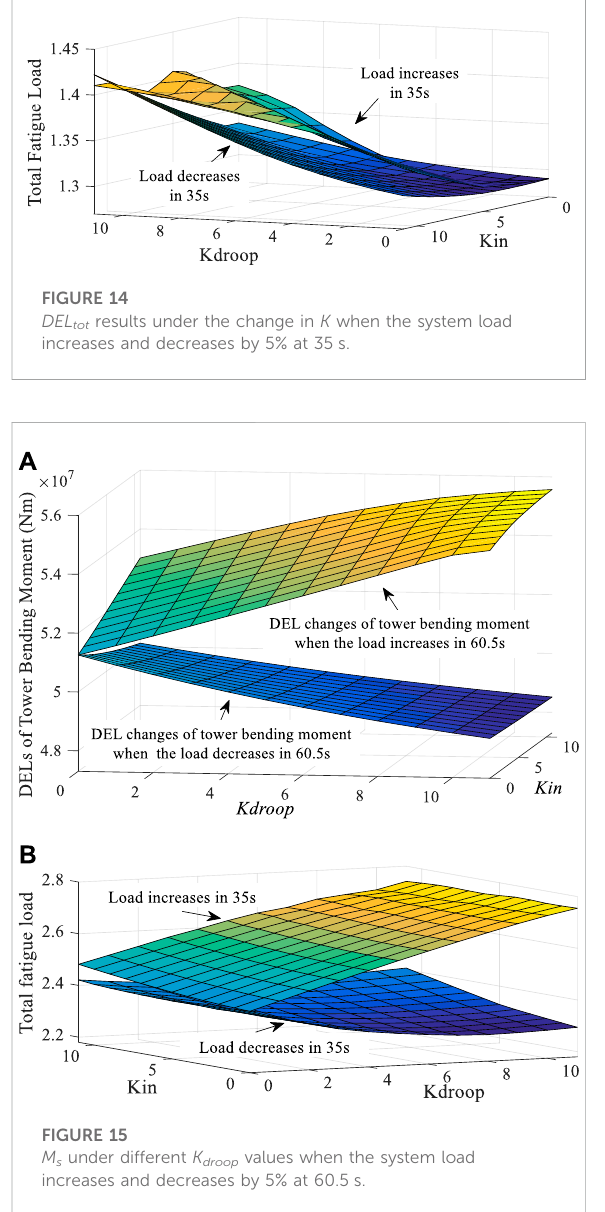
FIGURE 15 M s under different K droop values when the system load increases and decreases by 5% at 60.5 s.